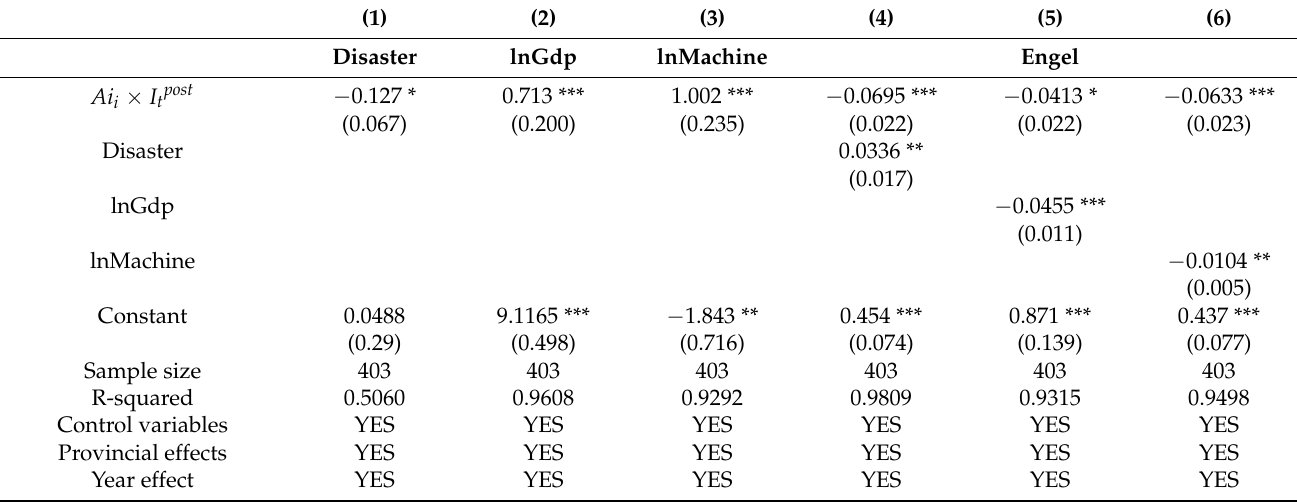
Table 7. Regression results for the mechanism